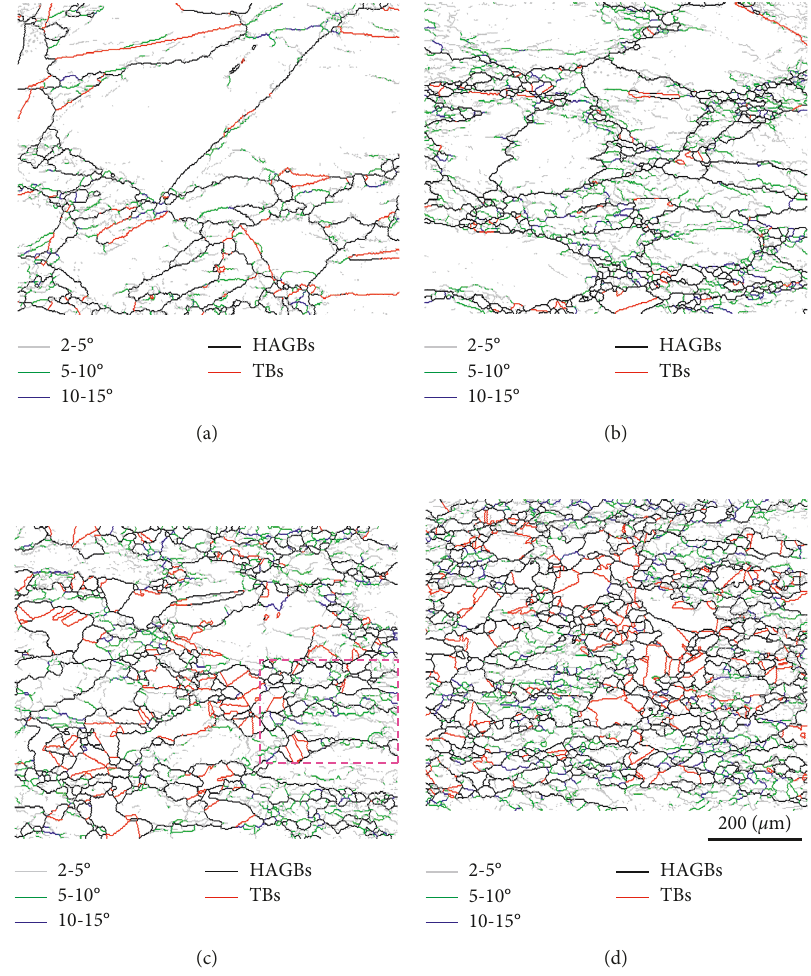
Figure 1: Microstructure of 18Mn18Cr0.6N steel compressed at 1050 ° C and 10 − 4 · s − 1 to different strains (vertical direction is the com- pression axis). (a) 0.2, (b) 0.4, (c) 0.6, and (d) 0.8.